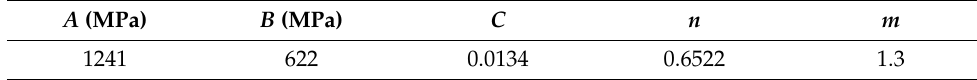
Table 2. Parameters of the J–C model for Inconel 718 material